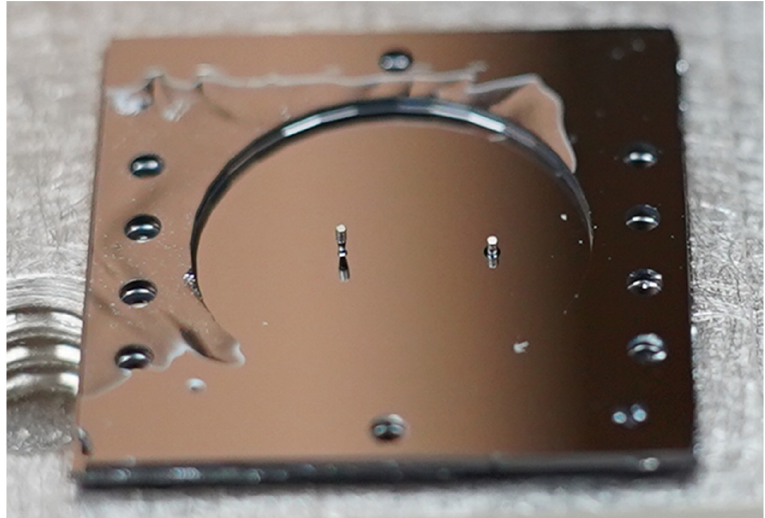
Figure 6. Photo of test structure with two magnets adhesively attached to the face sheet, one (left ) at the end of a post, and one ( right ) directly on the face sheet.